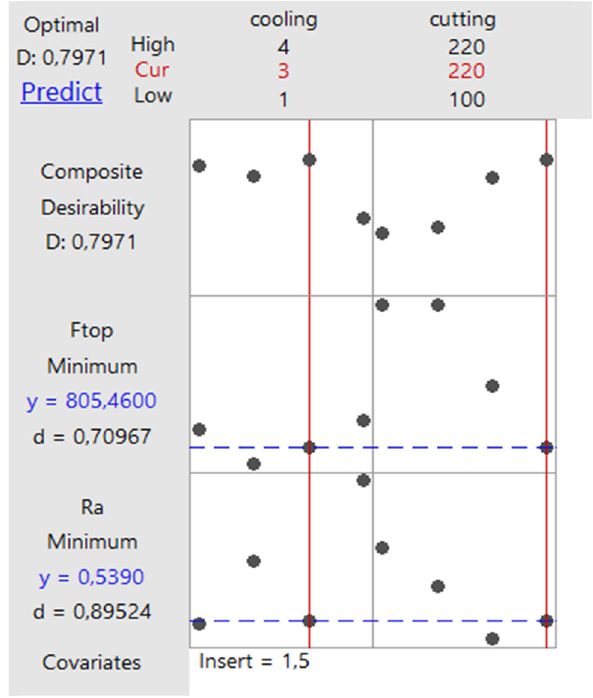
Figure 7: ANOVA optimization